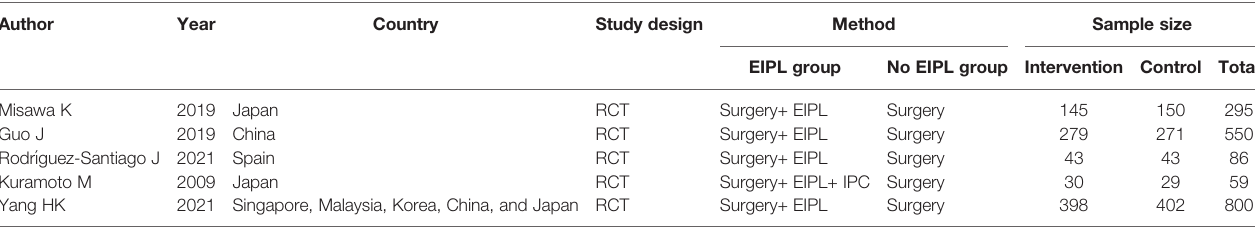
TABLE 1 | Characteristics of the included